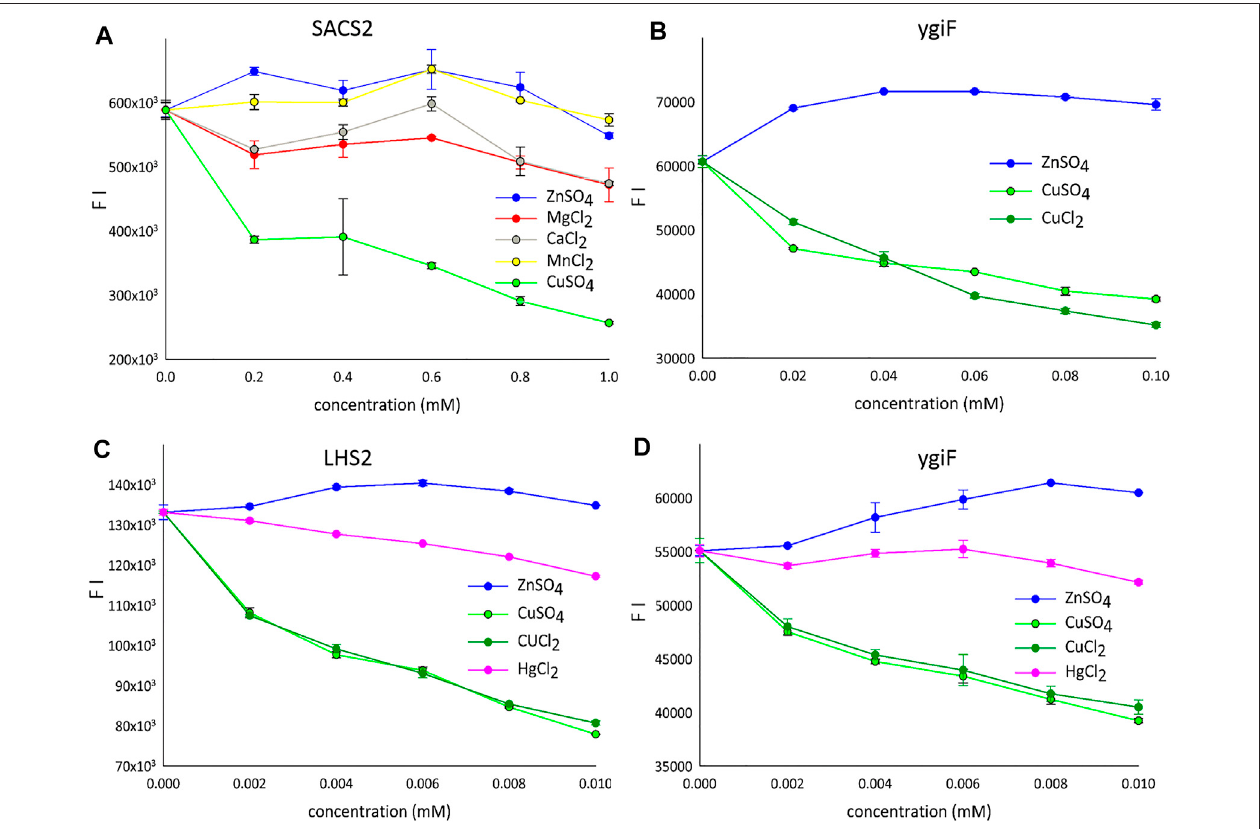
FIGURE2| Thedetectionofmetalions. (A) LHS1-SACS2/CHAD-turboGFPfusionconstruct(range:0.2 – 1 mM). (B) LHS1-turboGFP-ygiF/CHADfusionconstruct (range: 0.02 – 0.1 mM). (C) LHS2-turboGFP fusion construct (range: 0.002 – 0.01 mM). (D) LHS1-turboGFP-ygiF/CHAD fusion construct (range: 0.002 – 0.01 mM). FI means the fl uorescence intensity and only one protein is shown for the each concentration